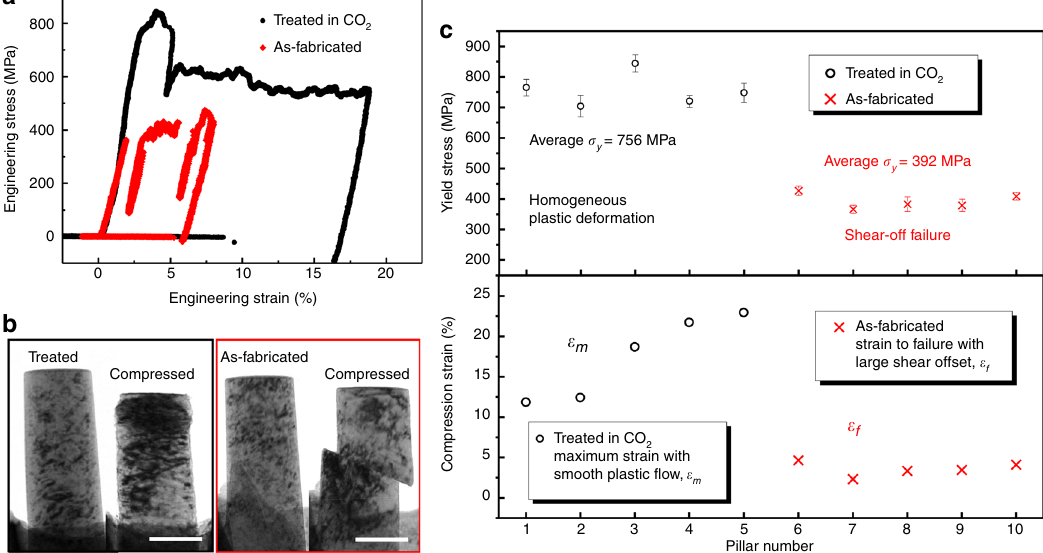
Fig. 5 Effect of the treated surface layer on the mechanical properties of the samples. a Typical compressive engineering stress-strain curves of an as- fabricated Mg pillar (red) and a pillar treated in CO 2 (black). Note both the yield stress and plastic deformation ability are improved signi fi cantly. b Bright- fi eld TEM images of the Mg pillar treated in CO 2 (framed in black) and an as-fabricated Mg pillar (framed in red) before and after compression. The MgCO 3 protective layer showed great adhesion to its substrate and excellent compatible deformation capability. c Statistics of the yield stress and compressive strain vs. the Mg pillars. Different from those as-fabricated Mg pillars that fail with large shear offset, the pillars with MgCO 3 protective layer deform homogeneously with smooth plastic fl ow with the maximus compressive strain up to 22%. The error bars are two standard deviations. Scale